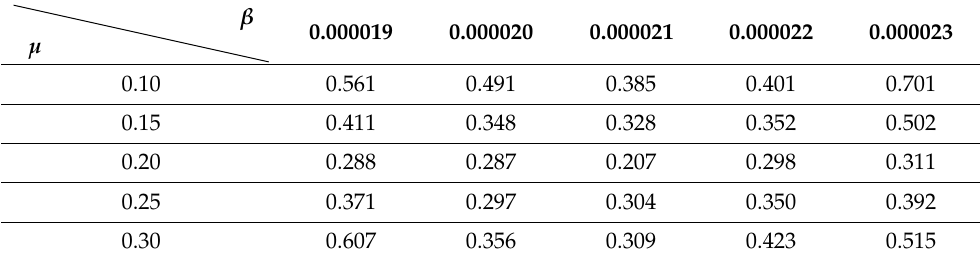
Table 1. Root mean square errors ( RMSE ) of infected sites for different values of β and µ .